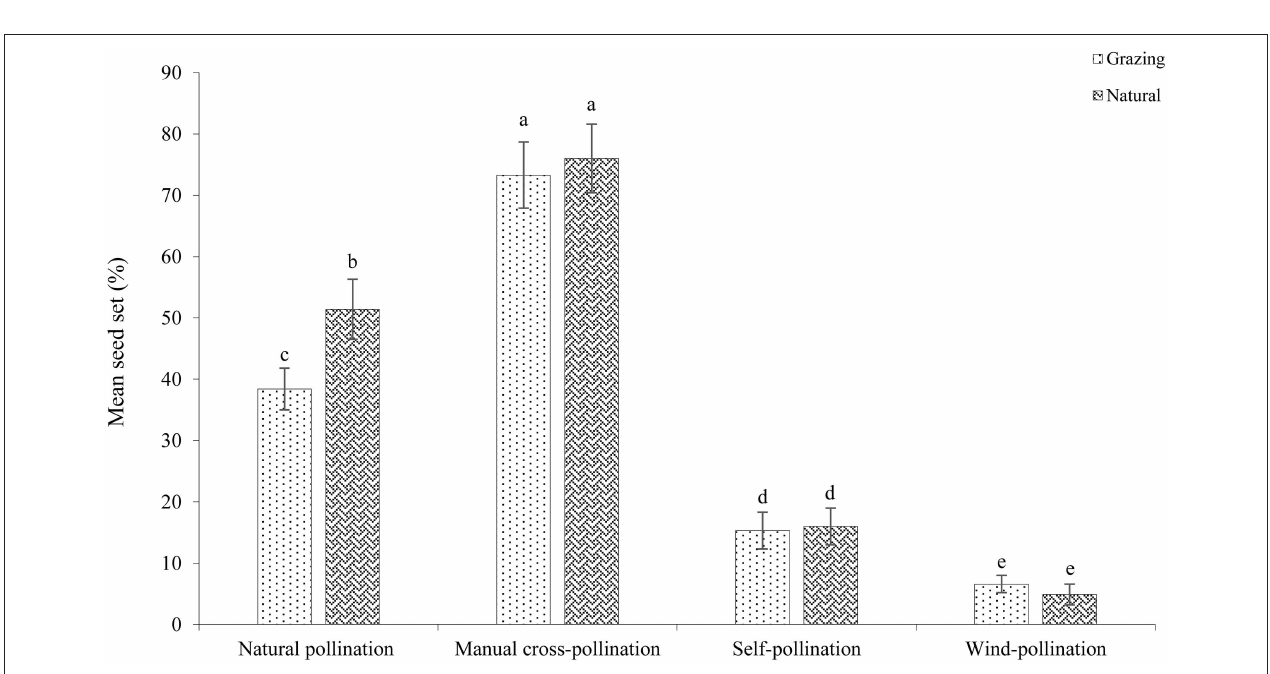
FIGURE 6 | Relationship between the pollinator visitation frequency and the number of open flowers in the studied patches.